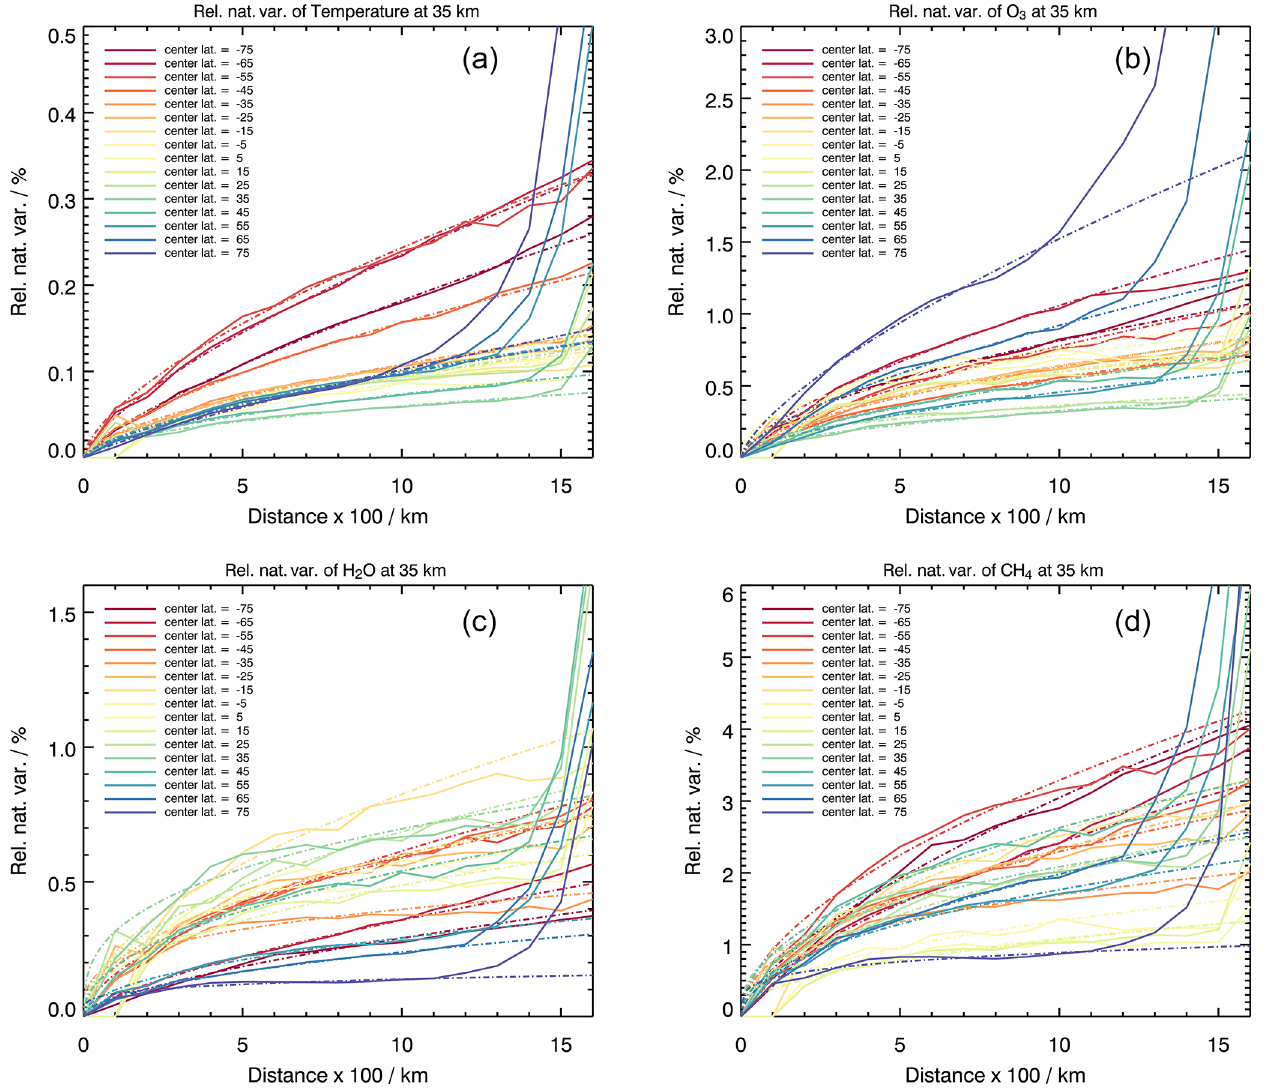
Figure 2. Natural variability as a function of horizontal distance for (a) temperature, (b) O 3 , (c) H 2 O and (d) CH 4 in the BASCOE model (solid lines) and the proposed parametrization (dashed lines) in different latitude